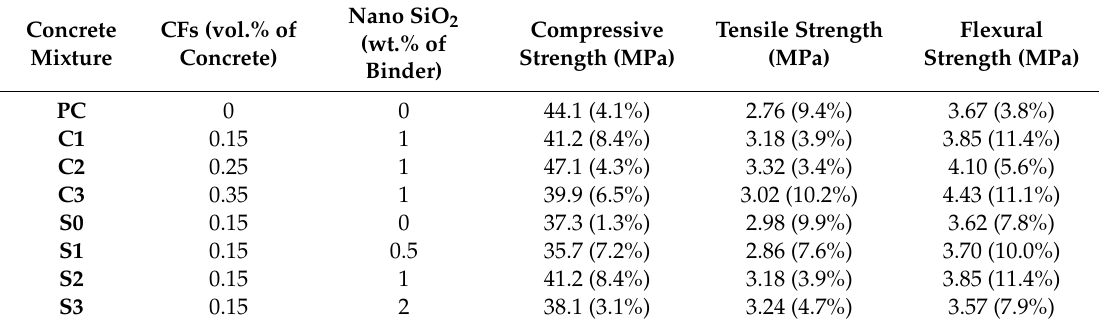
Table 3. Compressive strength, Splitting tensile strength and flexural strength of di ff erent NSCFRC.